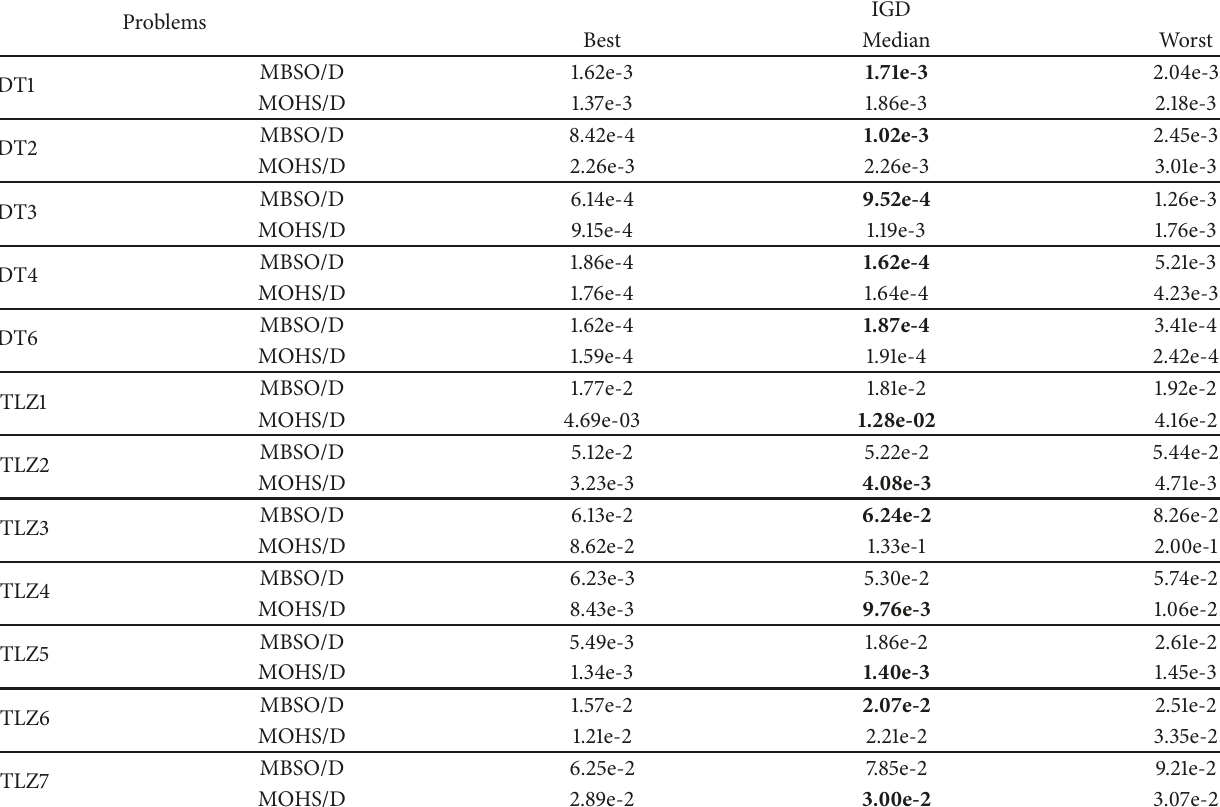
Table 3: IGD obtained by MBSO/D and MOHS/D on five ZDT problems and seven DTLZ problems.